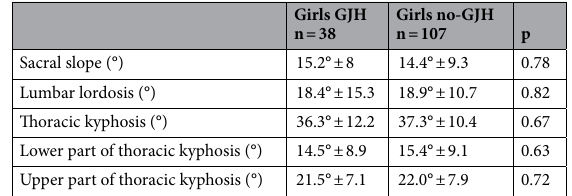
Table 3. Comparison of the sagittal curvatures of the spine in a relaxed sitting position between girls with (GJH) and without (no-GJH) generalized joint hypermobility.